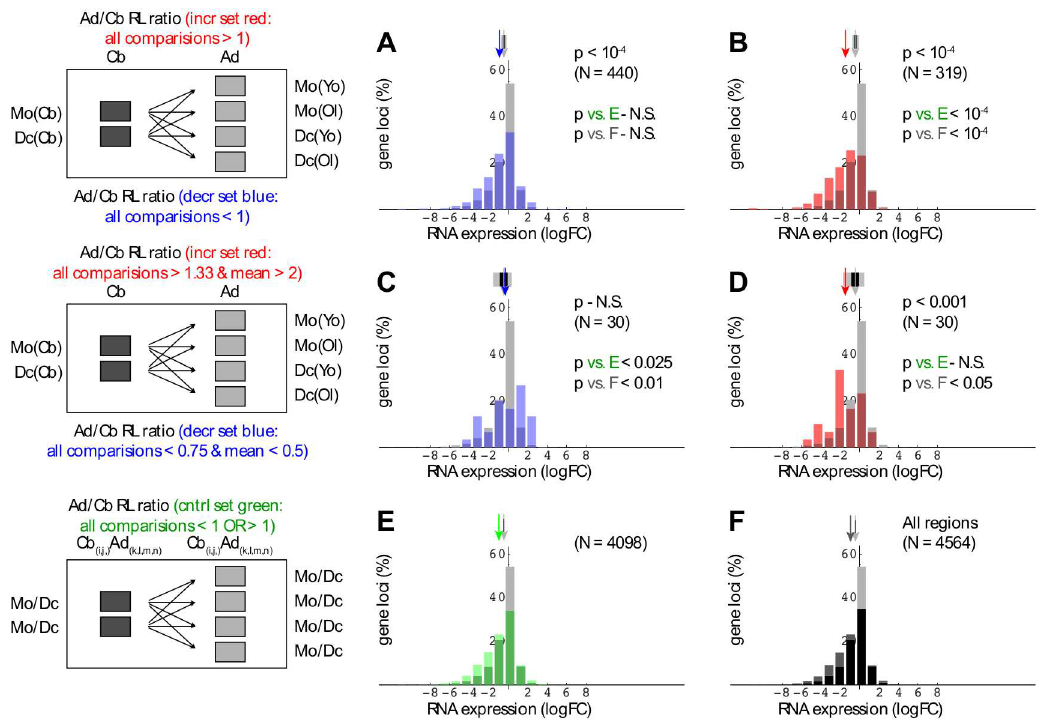
Fig 5. Associations between region span and postnatal monocyte gene expression change. Candidate change regions were identified based on consistent cord blood-adult span differences in multiple comparisons (explanatory schematics on left). While region estimates are derived from both monocyte and DC data, only monocyte RNA-seq data are shown in this figure (for DC expression data, see Fig 6). Minimum monocyte logCPM = -4.21. Plotting conventions are as in Fig 3.